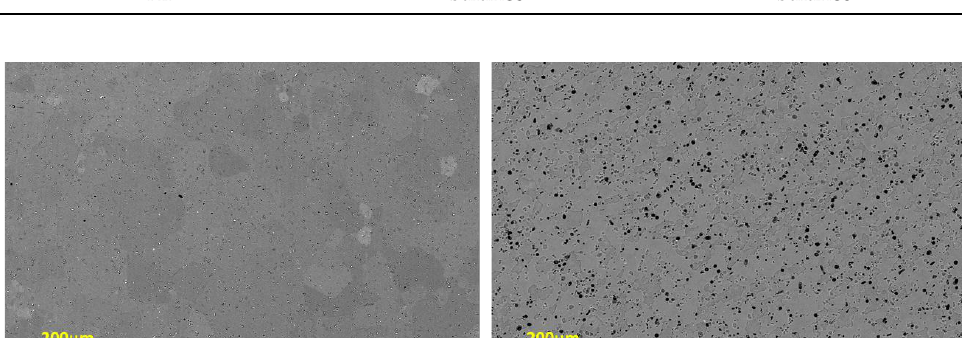
Figure 3. Microstructure of AA1050 (up) and AA6061 (down) specimens before DB experiments. Left — Optical microscope. Right — Electron microscope.